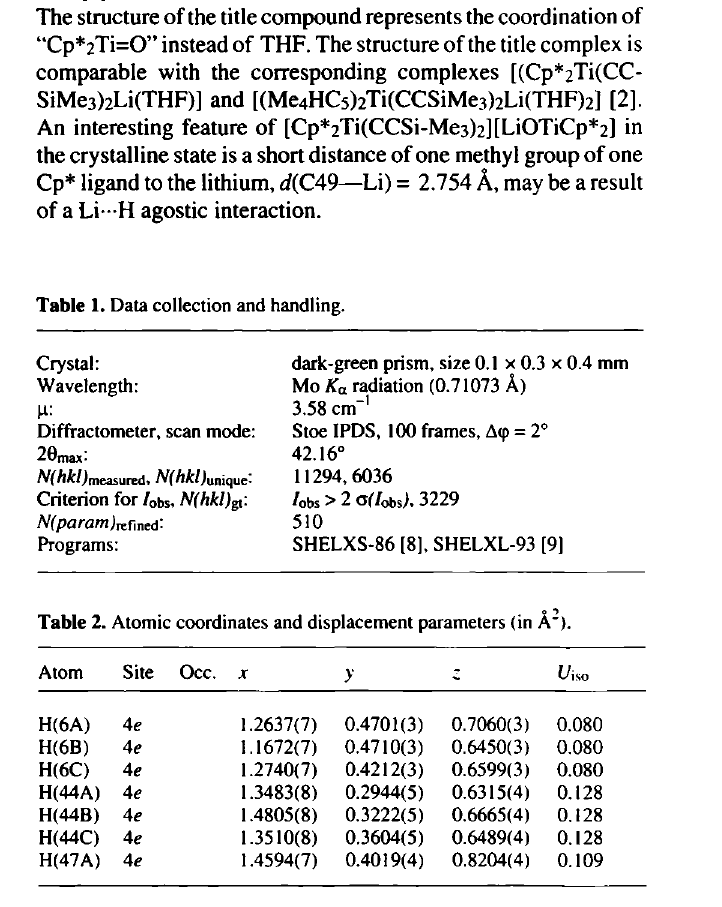
Table 2. Atomic coordinates and displacement parameters (in